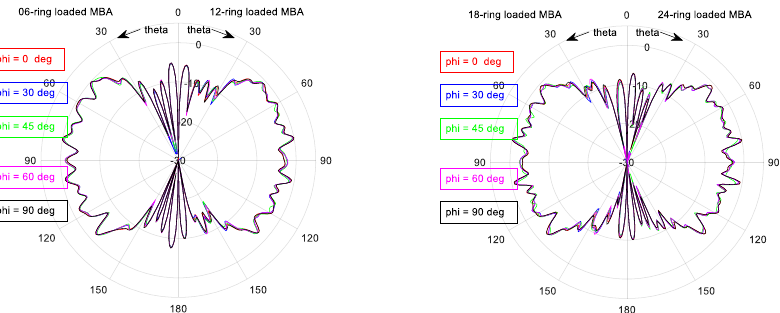
Figure A7. 2D patterns at 37 GHz of 6-, 12-, 18- and 24-ring-loaded MBA in different cutting